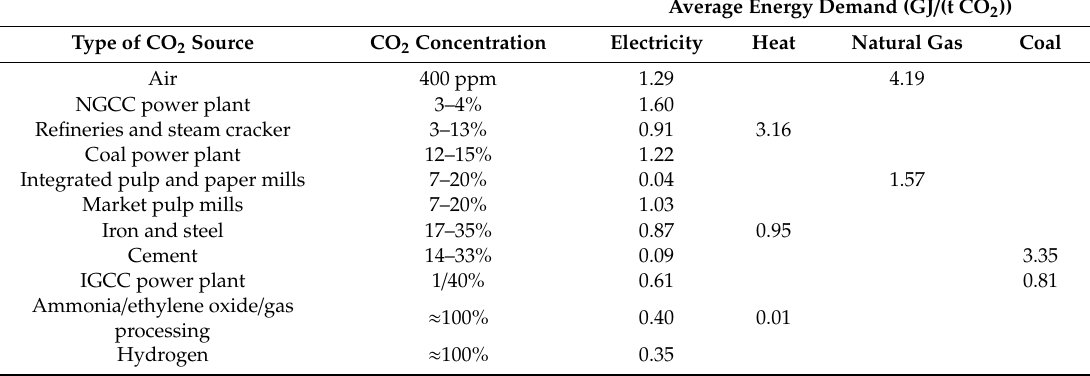
Table 3. Average specific energy consumption for CO 2 capture from di ff erent CO 2 sources in Europe. Data from